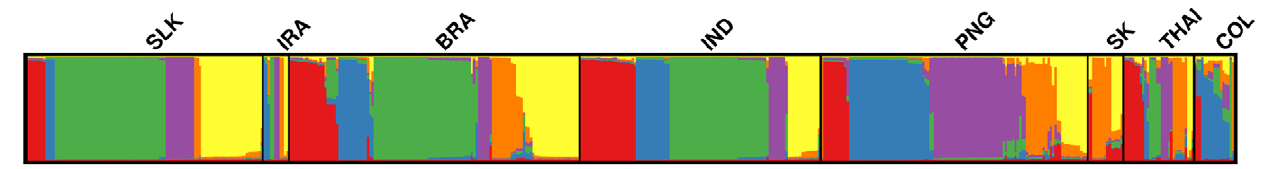
Figure 4. Population structure for P.vivax sequences of DBP II at K =6. Graphic of Structure results were produced by using the DISTRUCT program. Individual P. vivax isolate are represented by a thin vertical line from each geographic population showed above the graphic and separated by a thin black line. doi:10.1371/journal.pone.0022944.g004 PLoS ONE |